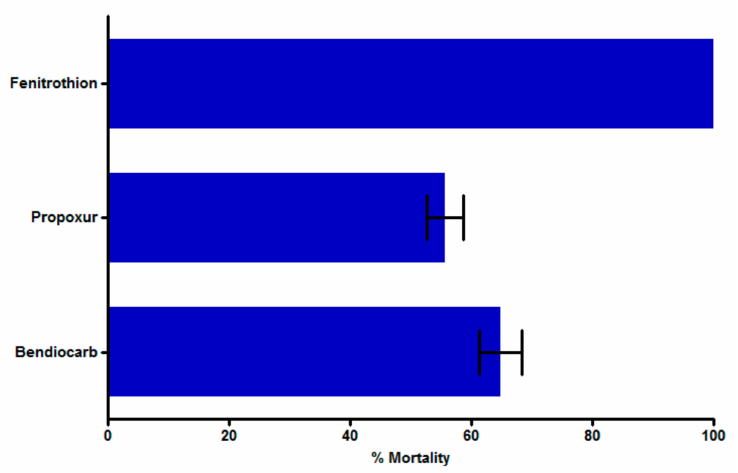
Figure 1. Susceptibility status of Anopheles gambiae mosquito population from Bankeng, central Cameroon. Mortality rates were recorded 24 h post-exposure to insecticides. Data are shown as mean ± standard error of the mean (SEM) ( n =